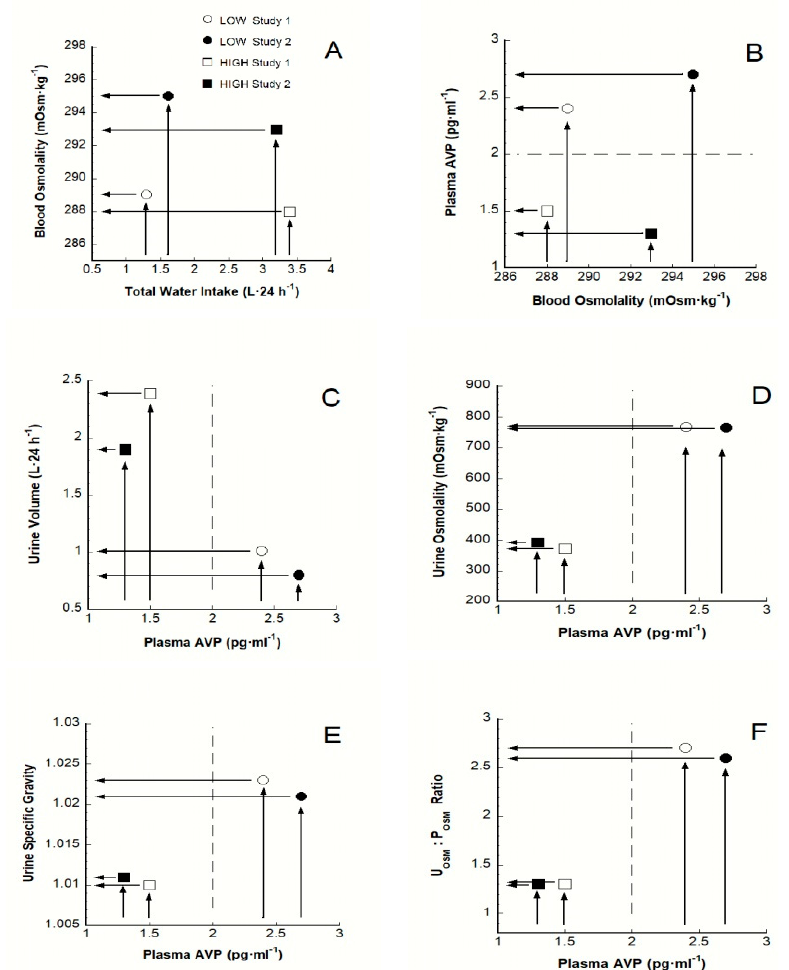
Figure 4. Relationships among total water intake, osmolality, AVP and four hydration biomarkers of LOW ( ○ ● ) and HIGH ( □ ■ ). A small blood osmolality difference (LOW versus HIGH; panels A and B ) results in the subsequent responses illustrated in panels B–F . The plasma AVP threshold of 2 pg·ml -1 (see Section 3 above) is depicted as a dashed line in panels B-F . Open symbols represent study 1 [20] and closed symbols represent study 2 [21] baseline mean values (see columns 2 and 3 of Table 1). Arrows aid visual discrimination of LOW and HIGH values in studies 1 and 2. The blood osmolality reference range of laboratory values for healthy adults (panels A and B) is 285–295 mOsm · kg − 1 [47]. ( A ): the influence of TWI on blood osmolality; ( B ): the influence of blood osmolality on plasma AVP concentration; ( C ): the influence of plasma AVP on urine volume; ( D ): the influence of plasma AVP on urine osmolality; ( E ): the influence of plasma AVP on urine specific gravity; ( F ): the influence of plasma AVP on the ratio of urine osmolality-to-plasma osmolality.